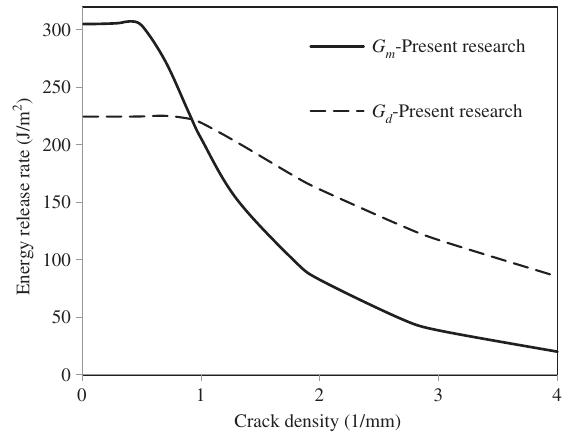
Figure 19: Crack density vs. energy release rate for [30/−30 epoxy laminate under σ